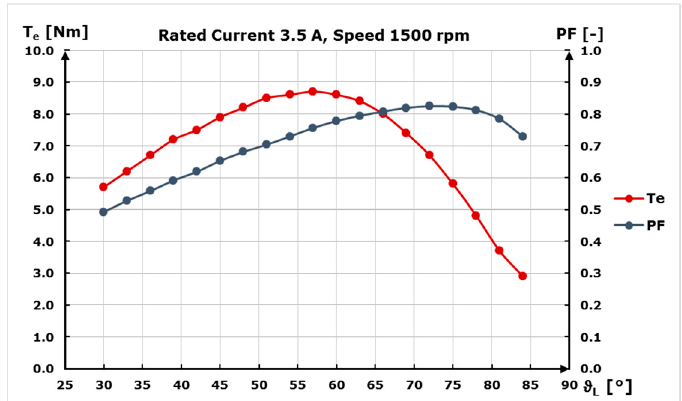
Figure 10. Torque and Power Factor versus load angle at 1000 rpm and rated current.